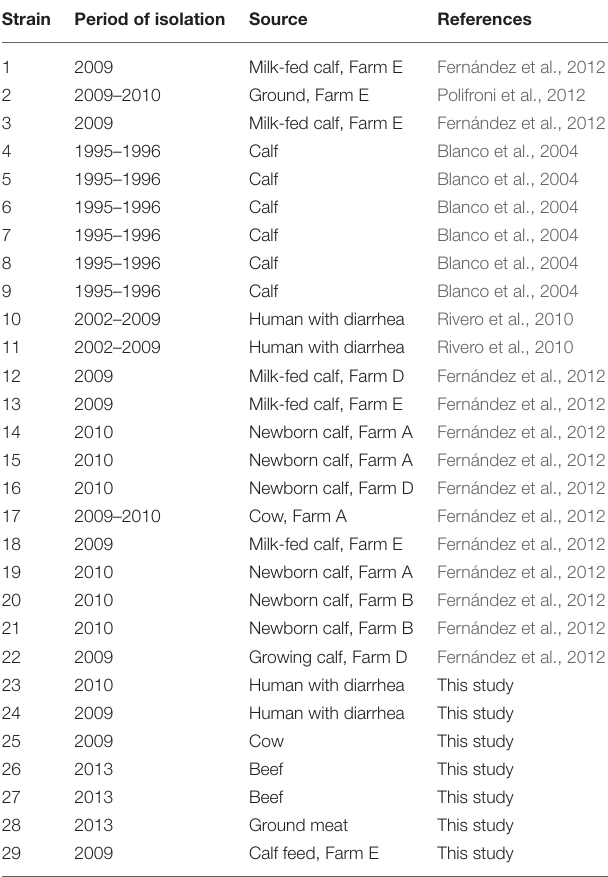
TABLE 1 | Characteristics of O26:H11 STEC isolates tested in this